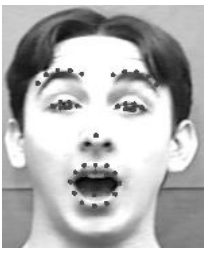
Figure 6. Facial feature points on a face image.